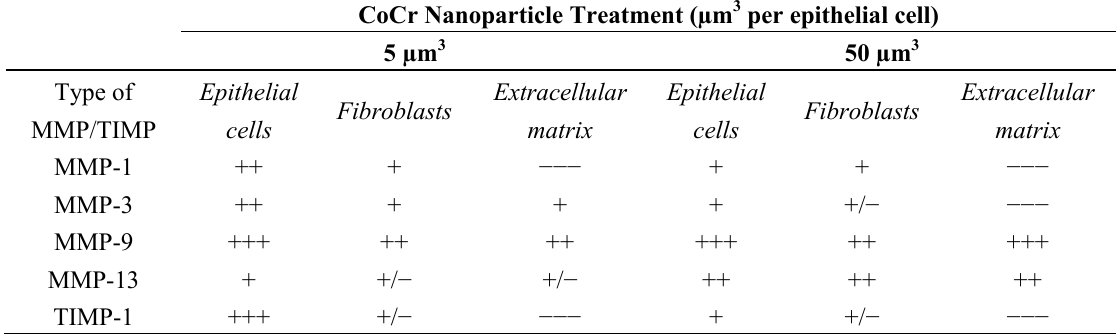
Table 1. Expression pattern of different matrix metalloproteinases in dural epithelial and fibroblast cells as well as in the extracellular matrix exposed to CoCr wear nanoparticles of different doses. Control tissues showed no positive staining and are not included. (Intensity of staining was assessed as: −−− : no staining, +/ − : very light staining, +: light staining, ++: strong staining, +++: very strong